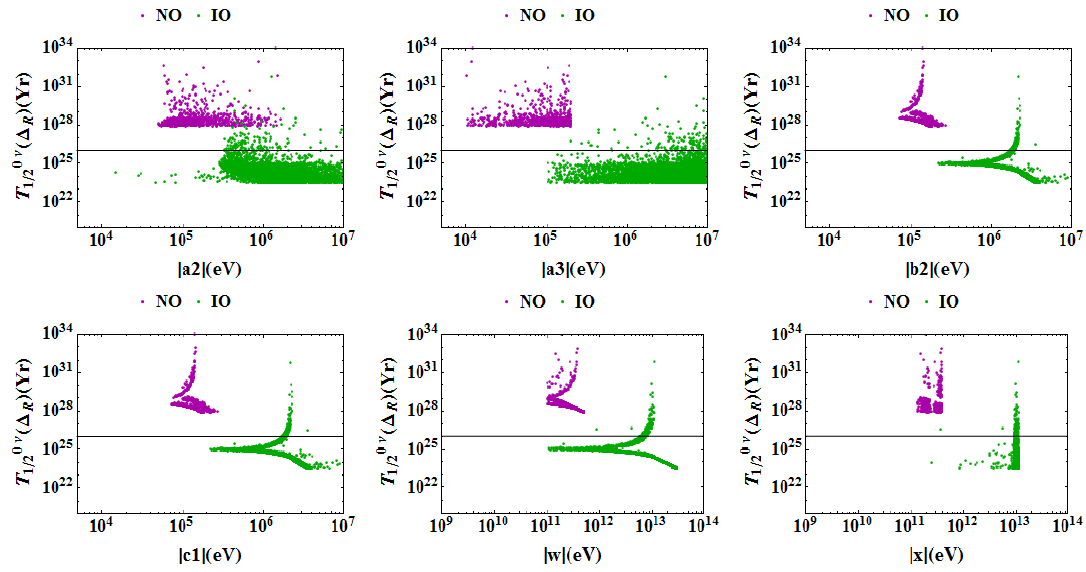
JHEP06(2019)064 Figure 12 . Heavy (cid:1) R contribution to half-life governing NDBD as a function of model parameters for the class B1. The horizontal line represents the KamLAND-Zen lower limit. Figure 13 . Heavy (cid:23) (N) contribution to half-life governing NDBD as a function of model param- eters for the class B2. The horizontal line represents the KamLAND-Zen lower limit. { 25